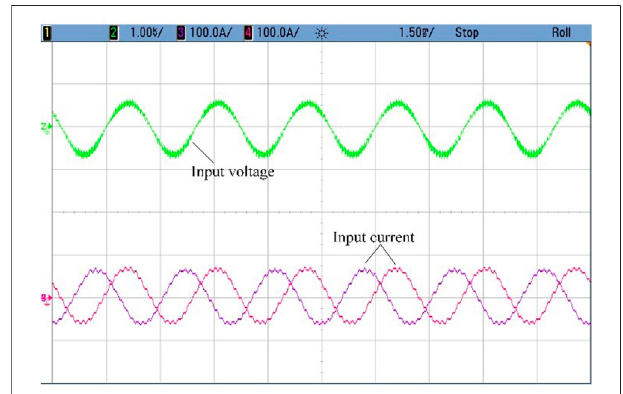
FIGURE 9 | Liquid nitrogen ( − 196 ° C) test device. FIGURE 10 | Measured waveforms of voltage and currents in liquid